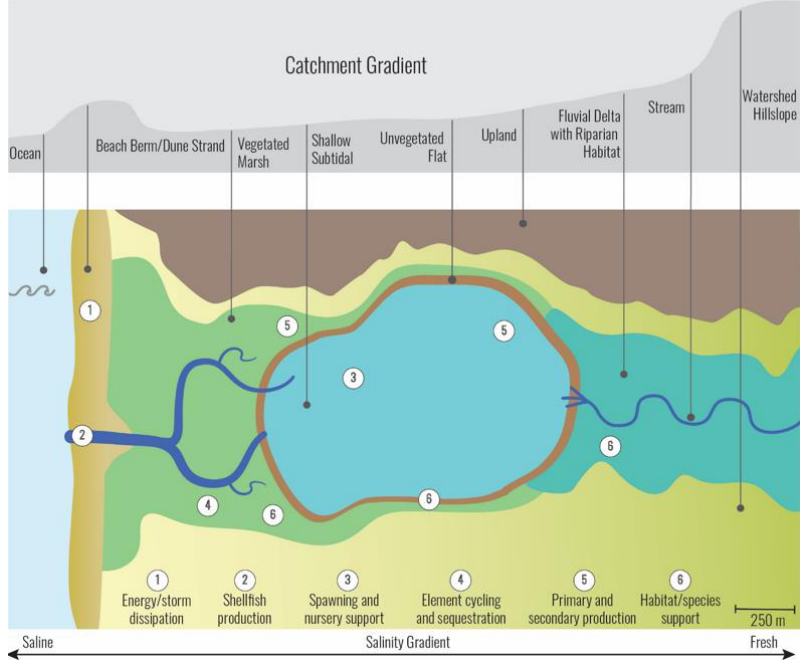
Figure 3. Schematic diagram of an estuary depicting major habitat types and associated functions along a characteristic salinity gradient. Numbers correspond to locations where functions listed at the bottom are expected to occur.